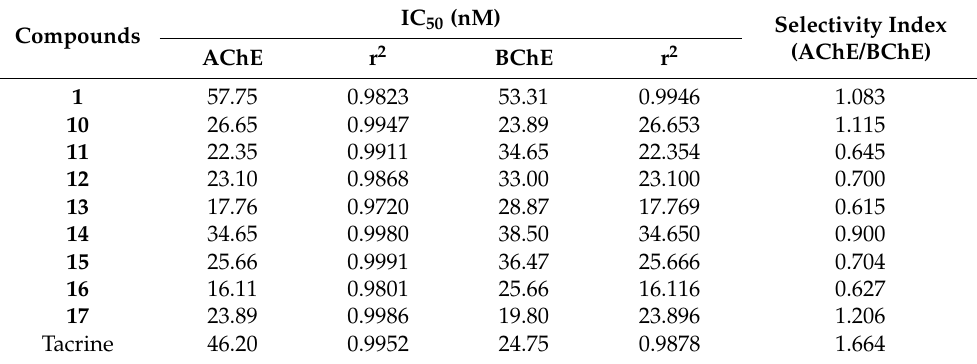
Table 4. The inhibition parameters of Schiff bases ( 10 – 15 ) and hydrazineylidene derivatives ( 16 and 17 ) towards AChE and BChE.